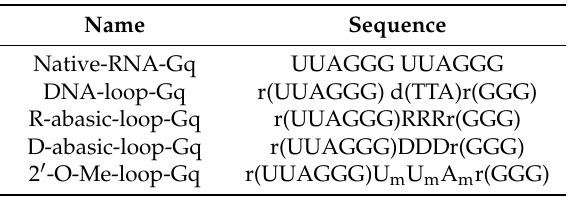
Table 1. Sequence of oligonucleotides used in this